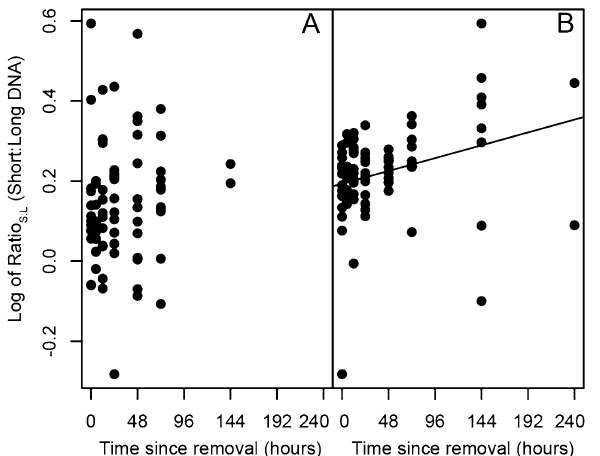
Figure 4. Temporal changes in log 10 Ratio S:L (short:long) for ( A ) 16S mitochondrial (mt) ribosomal (r)DNA ( p > 0.05) and ( B ) H2B nuclear (nu) messenger (m)DNA ( p = 0.004**, R 2 = 0.09).